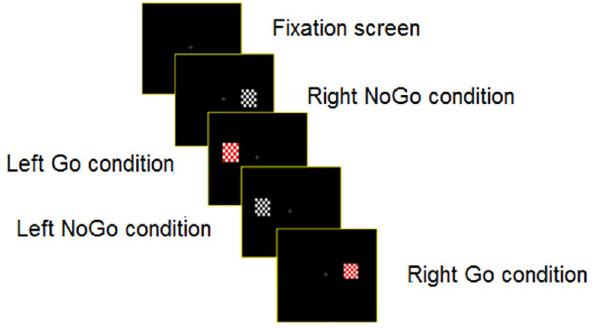
Figure 1. Experimental task (the Go/NoGo paradigm). Four conditions randomly occurred during the experiment. The stimulus duration was 500 ms, and the SOA interval was 1000